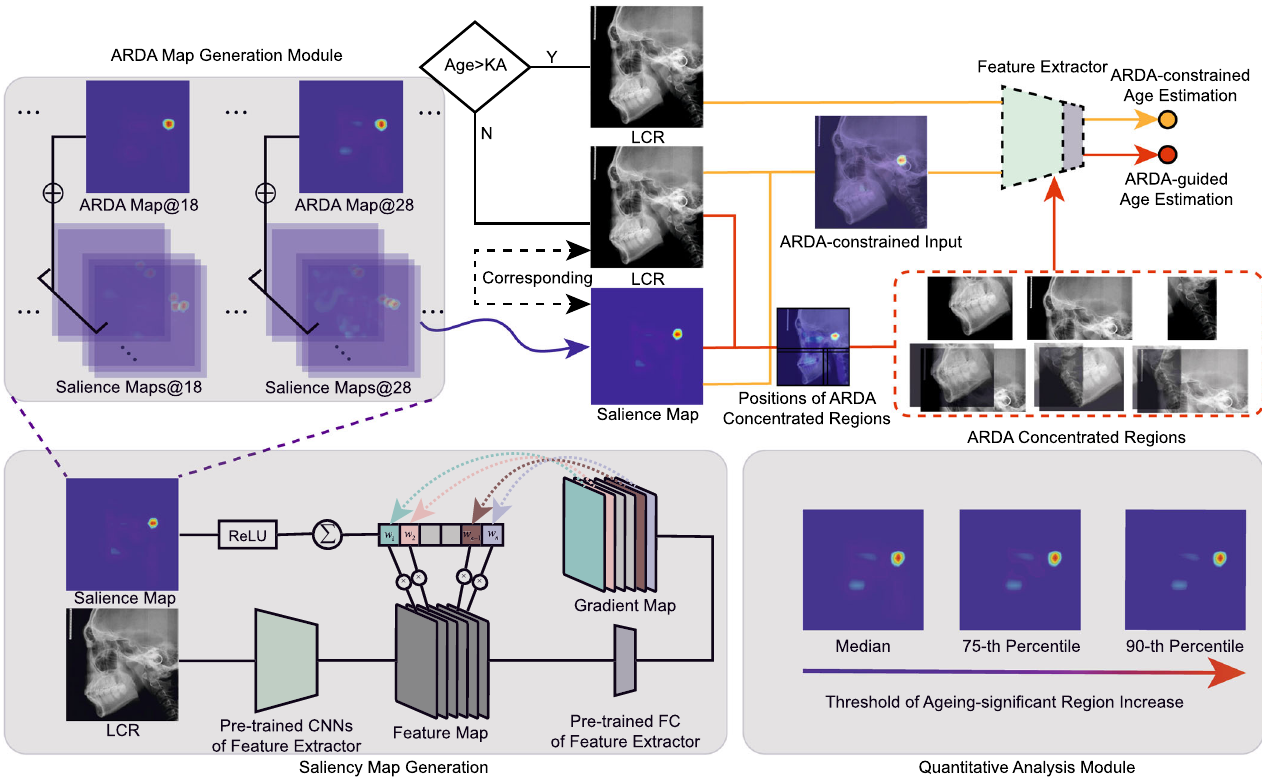
Fig. 10 Overview of the method used in this study. The method includes ageing feature extraction, ageing salience map generation and ARDA generation, three ARDA concentrated regions acquisition and quantitative analysis of ageing distribution modules. The data fl ow of ARDA-constrained age estimation is indicated by yellow lines, while the data fl ow of ARDA-guided age estimation is indicated by red lines. The feature extractor and fully connected layer of the baseline model in the ARDA Map Generation Model are pre-trained.